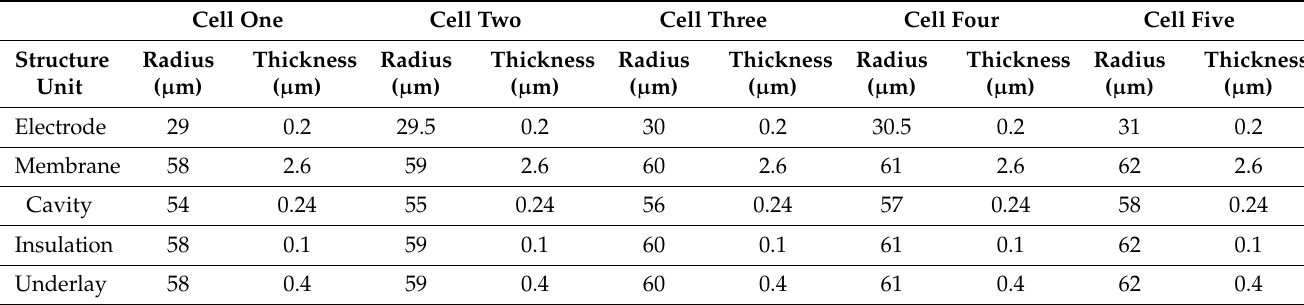
Table 4. Cell parameters for the five cell CMUT